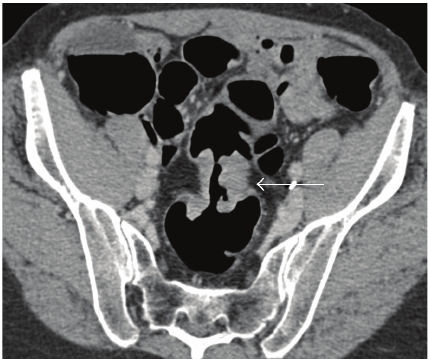
Figure 3: Carcinoma at the rectosigmoid junction at CT colonog- raphy. There is enhancing tissue at the rectosigmoid junction with circumferential wall thickening (arrow), shouldered margins, and luminal stenosis consistent with carcinoma.